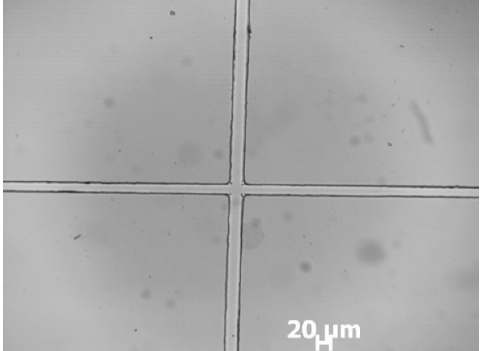
Figure 6. TiO 2 –SiO 2 grid observed using an optical microscope in a reflection mode (x20). The crossed TiO 2 –SiO 2 area is not affected by the double exposure (360 J/cm 2